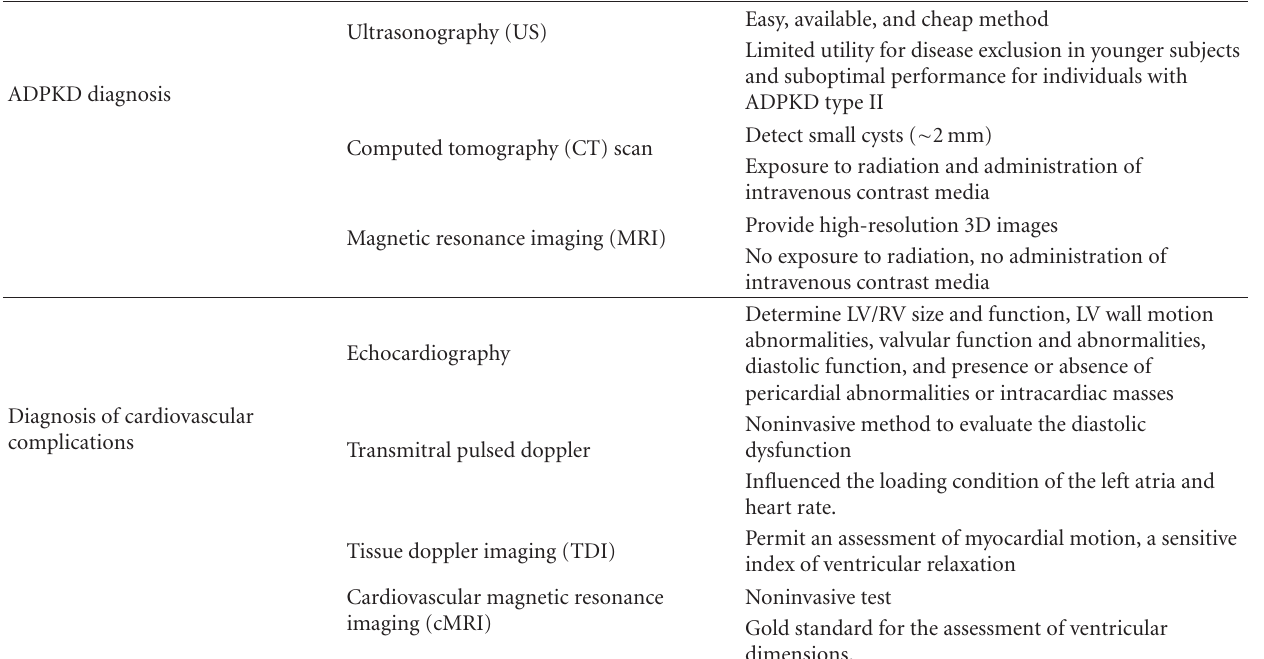
Table 2: Imaging